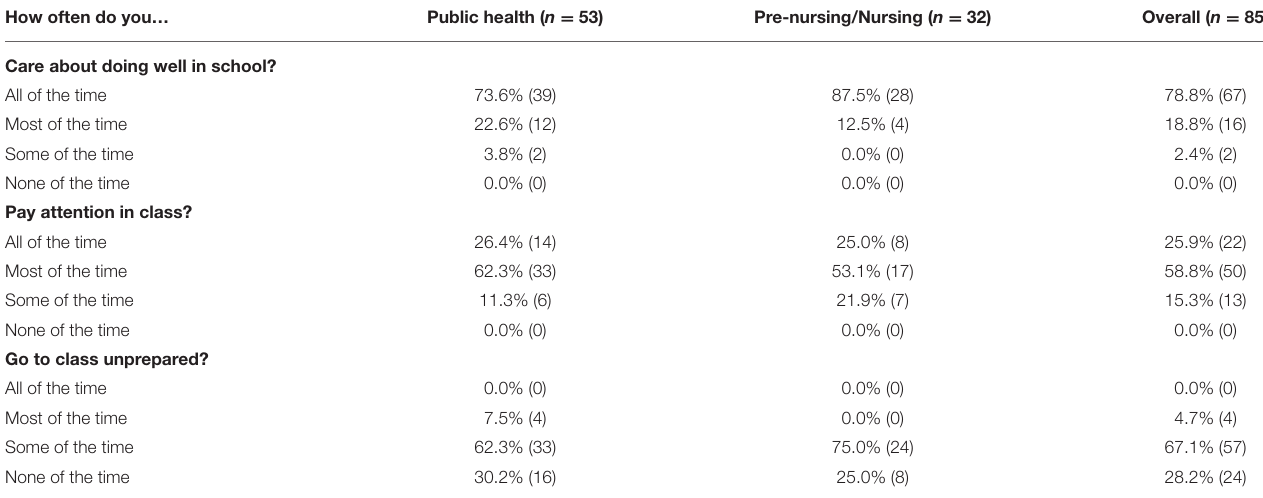
TABLE 2 | Academic behaviors by